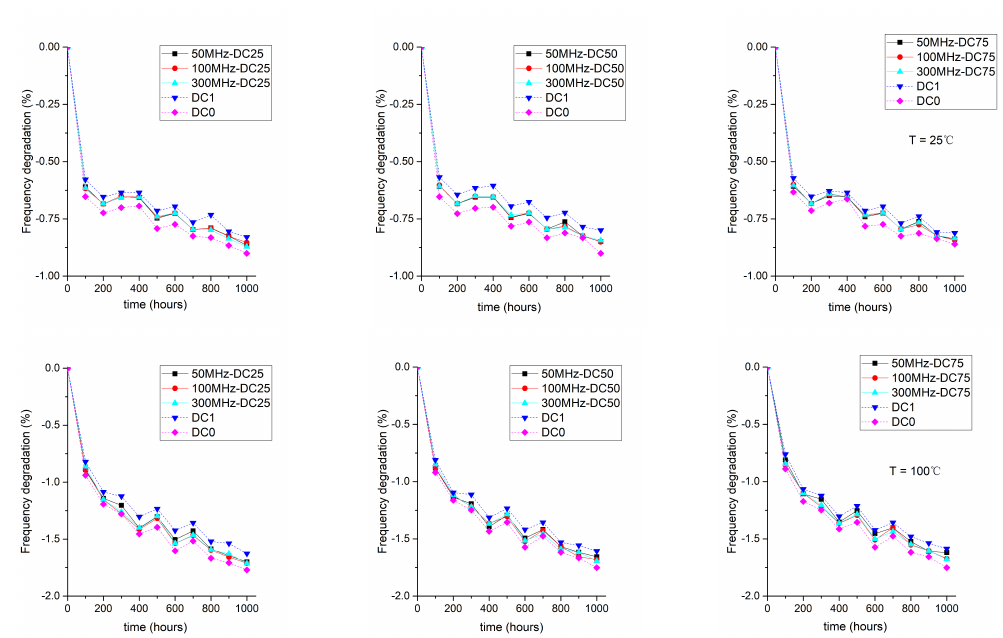
Figure 5. Impacts of stress signal frequency on the frequency degradation of ROs.